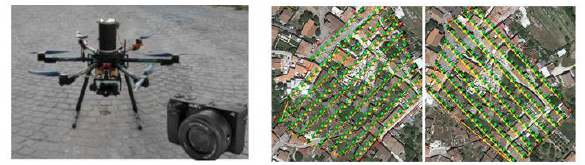
Figure 3. Flight Planning